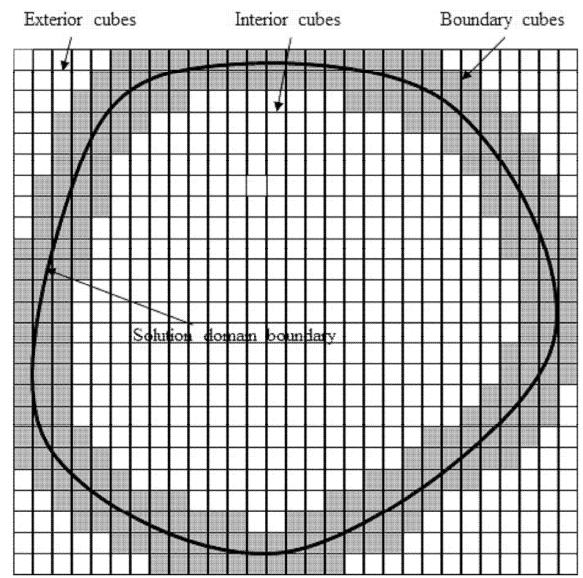
Figure 7. Di ff erent types of the background Figure 7. Different types of the background cubes.